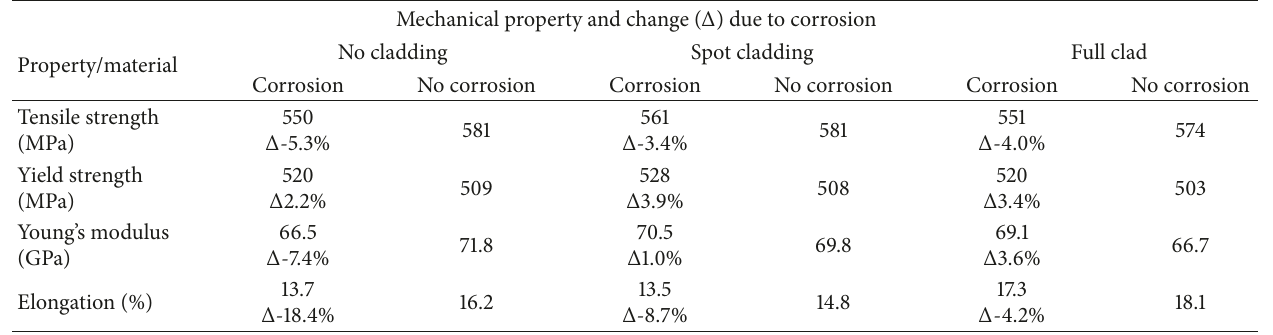
Table 1: Mechanical properties summary.